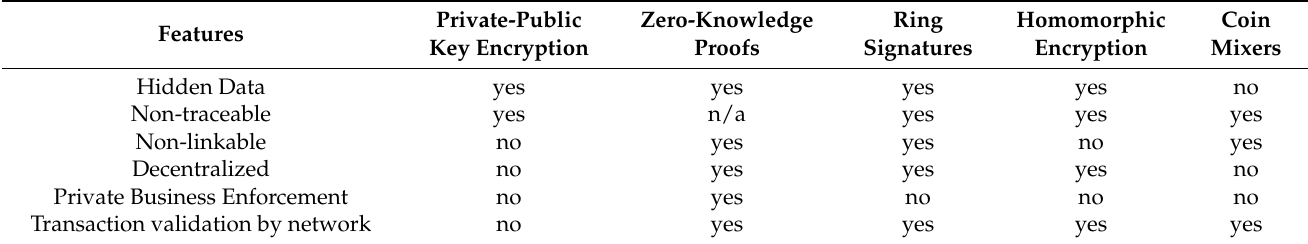
Table 2. DLT main privacy presenting